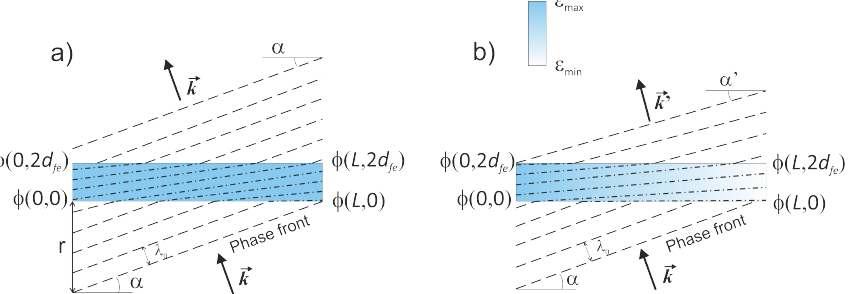
Figure A2. Schematic of the incident wave transmission through the ferroelectric plate with a constant permittivity value along the plate ( a ) and through the ferroelectric plate with the gradient permittivity distribution ( b